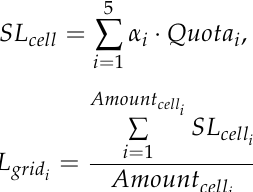
Figure 8. Safety indicator